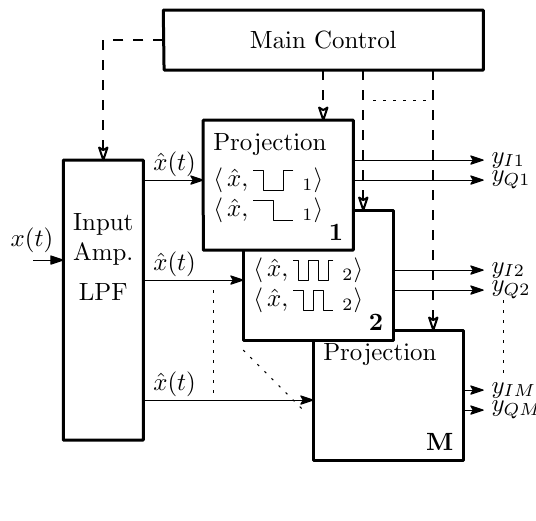
Figure 7. Analog projection system block diagram.